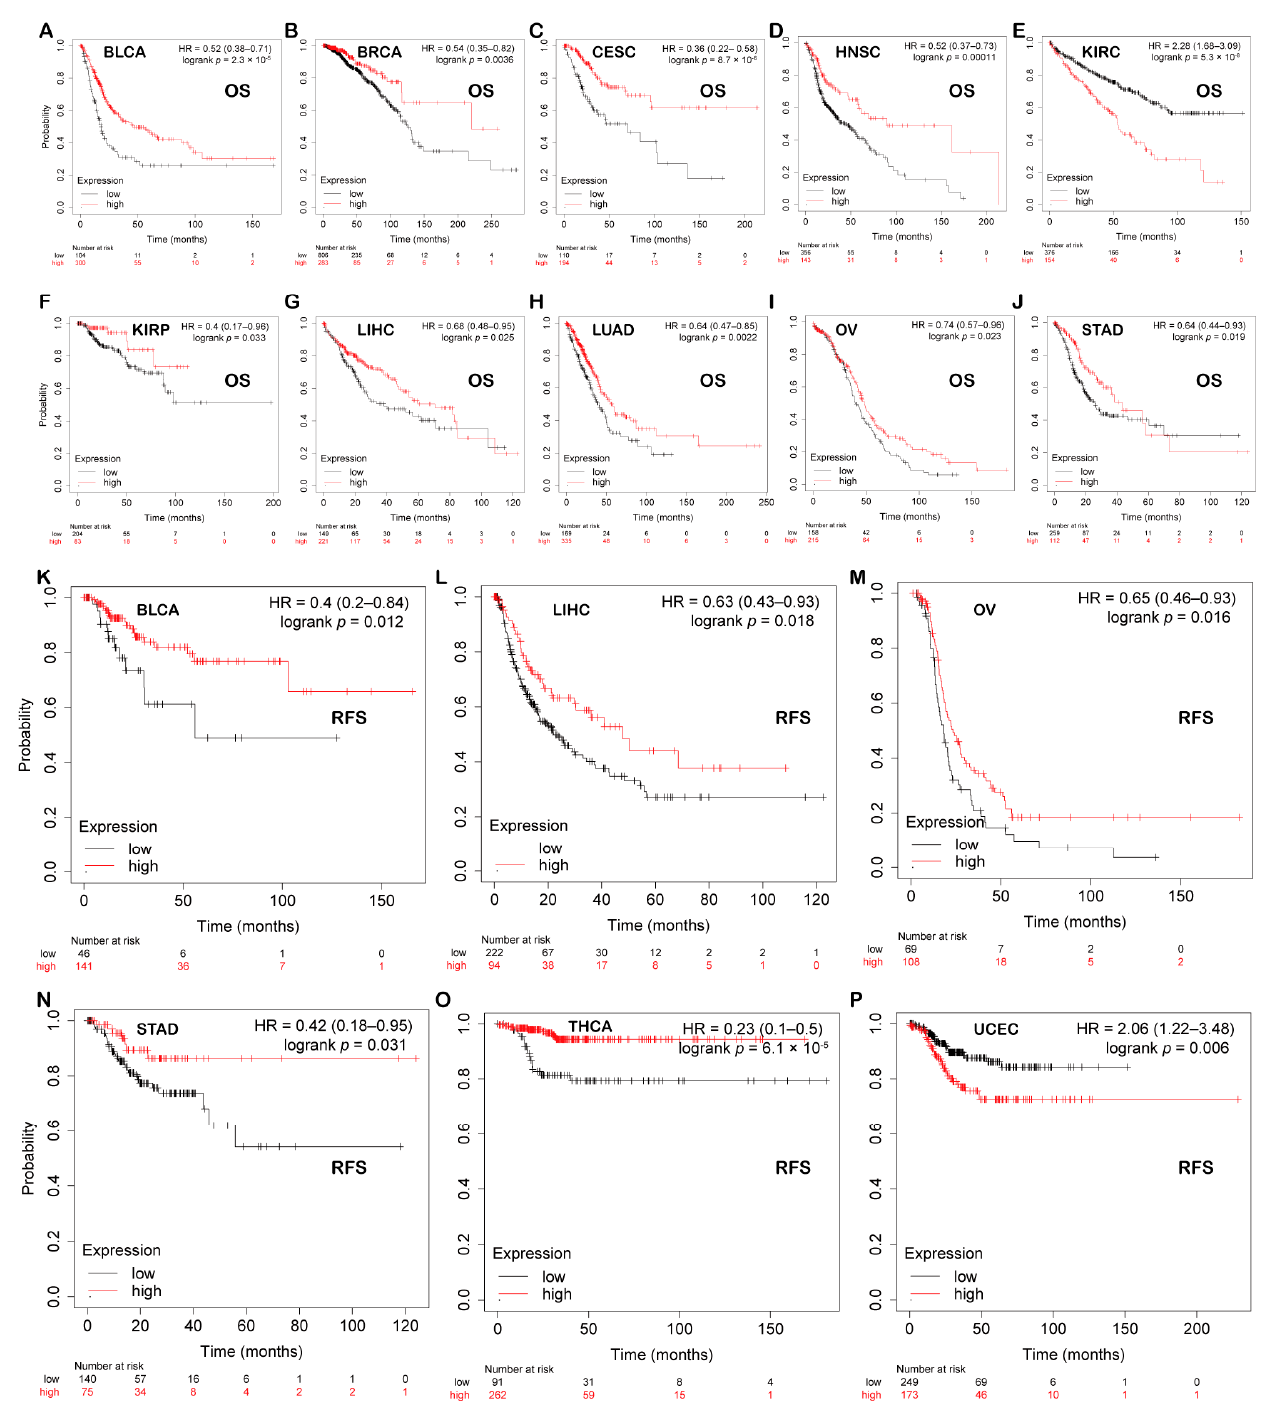
Figure 5. Prognostic value of PBX4 across human cancers with Kaplan–Meier plotter. Significant correlations between high-expression and low-expression groups of PBX4 and OS in ( A ) BLCA, ( B ) BRCA, ( C ) CESC, ( D ) HNSC, ( E ) KIRC, ( F ) KIRP, ( G ) LIHC, ( H ) LUAD, ( I ) OV, and ( J ) STAD. Significant correlations between high-expression and low-expression groups of PBX4 and RFS in ( K ) BLCA, ( L ) LIHC, ( M ) OV, ( N ) STAD, ( O ) THCA, and ( P ) UCEC.